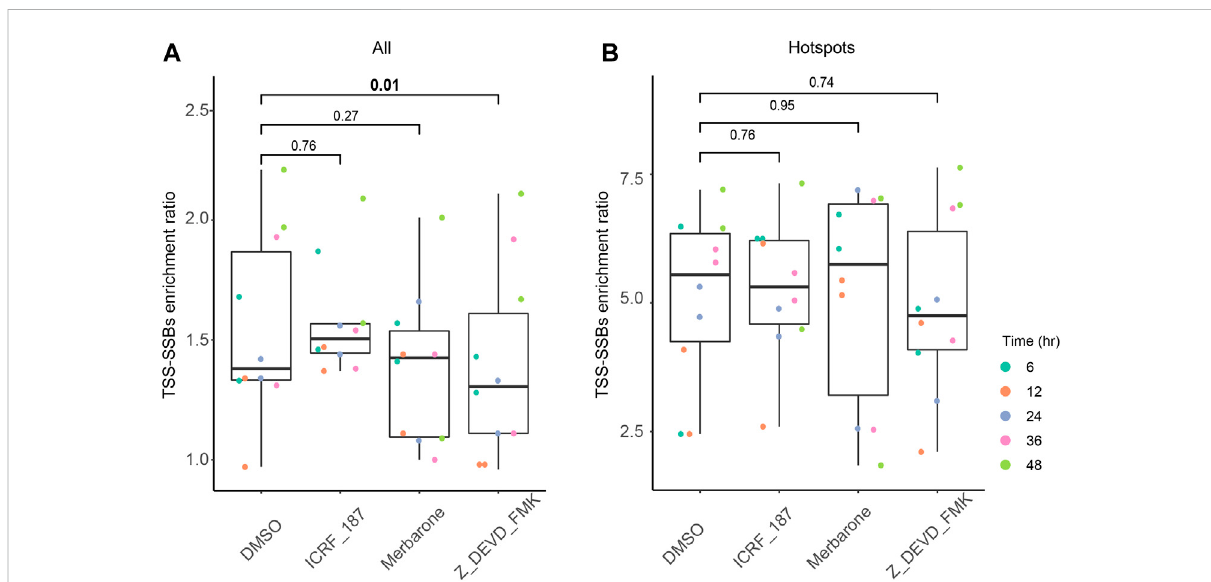
FIGURE 5 EffectsofthecaspaseandTOP2catalyticinhibitorsontherelativeenrichmentofallbreaksandhotspotsaroundTSSs.TheboxplotsoftheTSS- SSBs enrichment odds ratios (Y-axes) are shown for each time point (see the inset on the right) of each treatment (X-axes) for all breaks (A) and hotspots (B) . Thevertical connecting linesrepresent thecorresponding p -valuesofthedifferencesintheTSS-SSBsenrichmentoddsratiosbetween the various inhibitor treatments and the DMSO controls. See Supplementary Table S5 and Materials and Methods for more